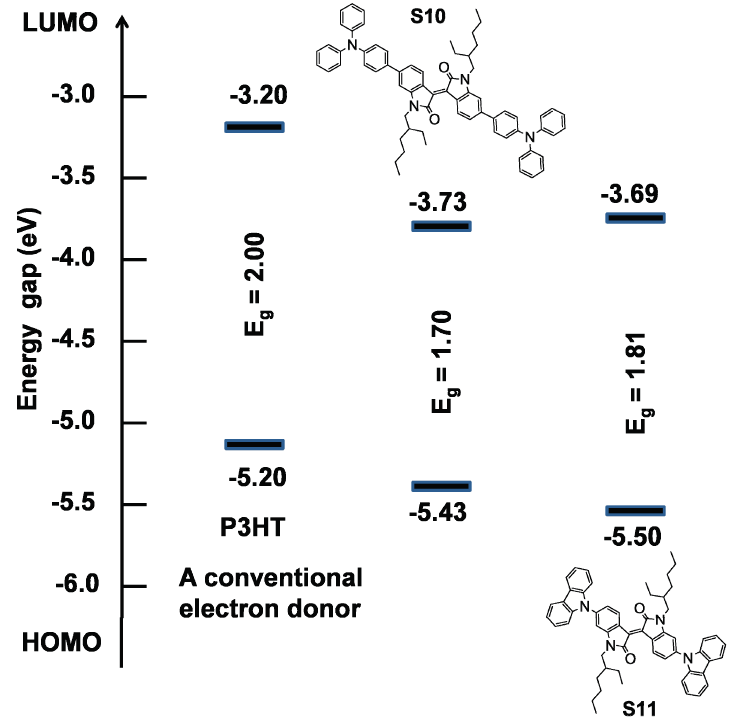
Figure 4. Energy level diagram depicting HOMOs LUMOs of S10 and S11 , where HOMO levels were measured using PESA on thin solid films and LUMO levels were calculated from the optical band gaps and HOMO levels (E LUMO = E bandgap + E HOMO